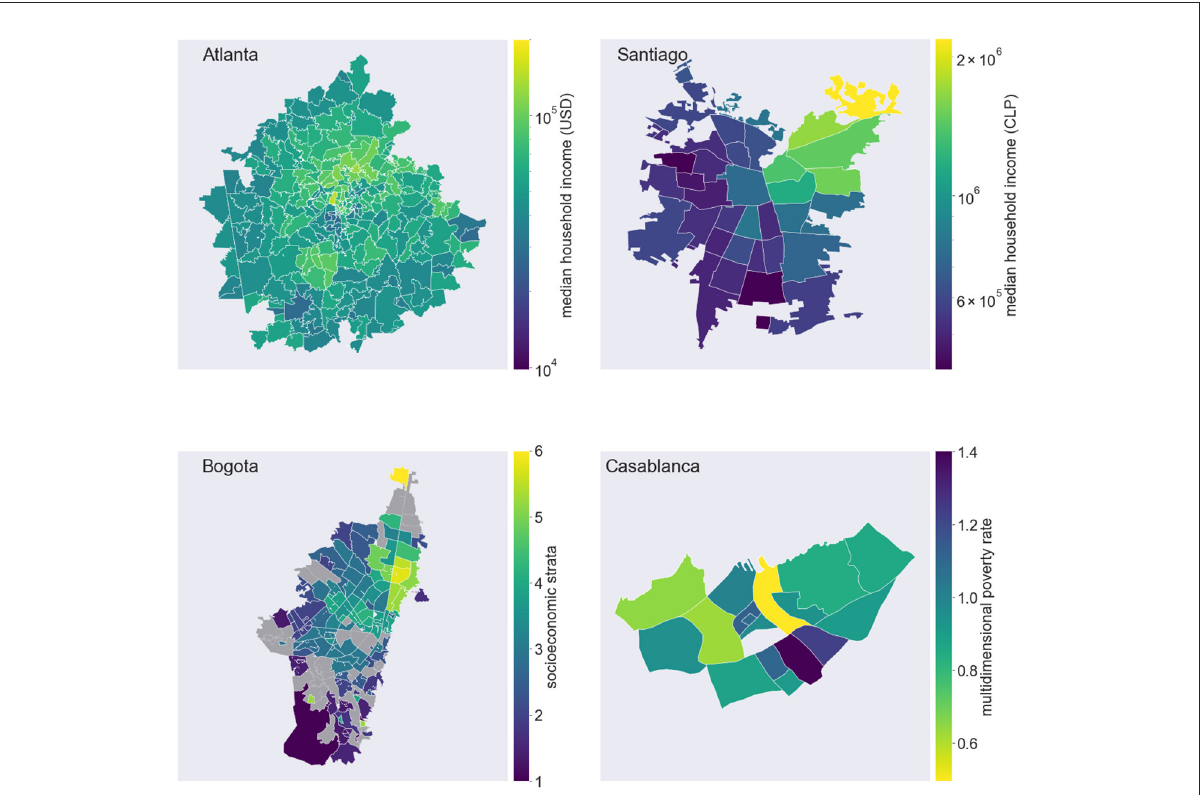
FIGURE1 Spatial distributions of socioeconomic indicators. Choropleth maps display the values of socioeconomic indicators in the cities of Atlanta, Santiago, Bogotá and Casablanca. From top to bottom: median household income in Atlanta, USA, by zip code; median household income in Santiago, Chile, by comuna; socioeconomic strata in Bogotá, Colombia, by UPZ (missing data are colored in gray); multidimensional poverty rate, in Casablanca, Morocco, by